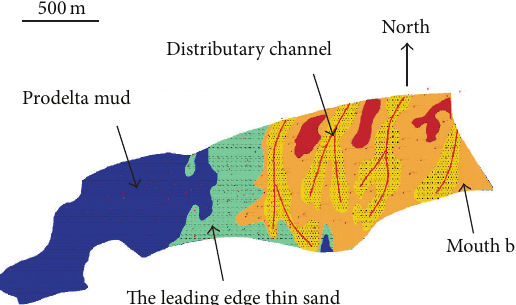
Figure 10: The microfacies of SHA1 reservoir.